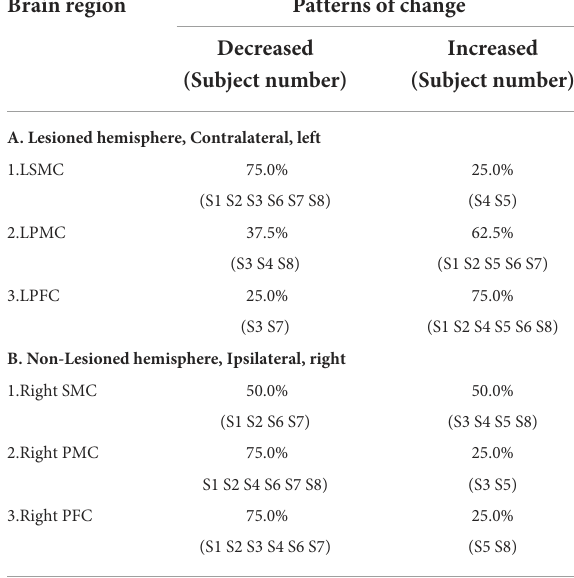
TABLE 3 Change Patterns of brain regions from pre-intervention to post-intervention according to β value. Brain